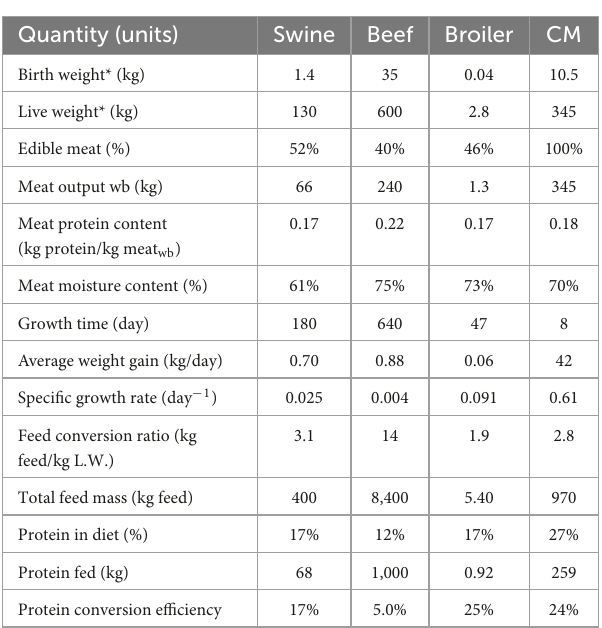
TABLE 2 Growth and feed use characteristics of beef, swine, and broilers compared to cultured